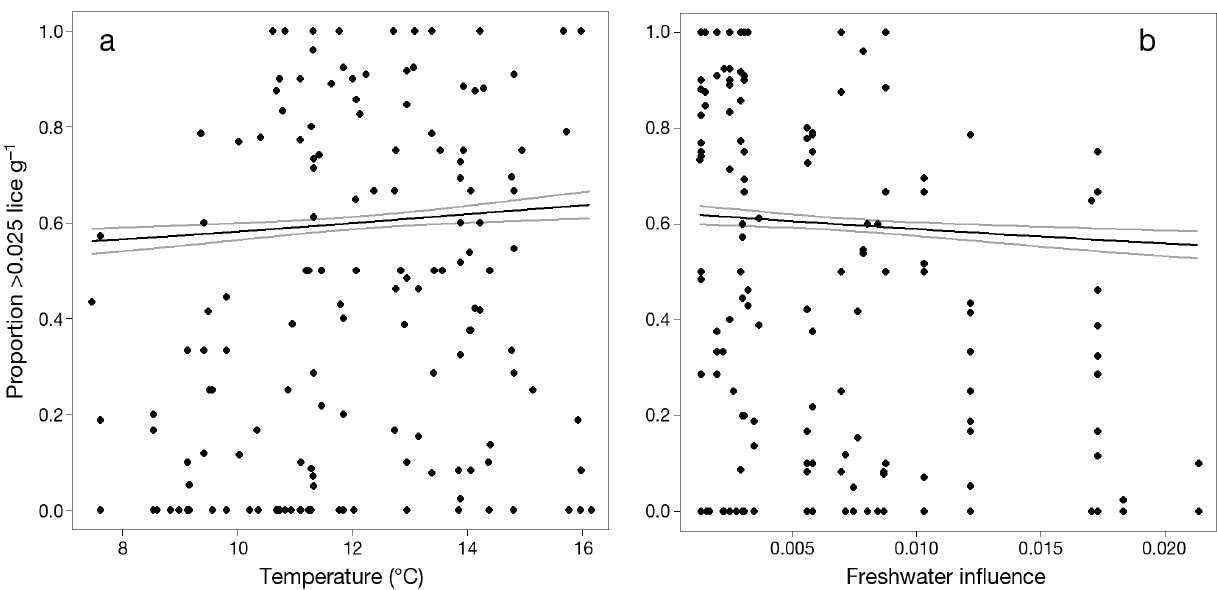
Fig. 5. Proportion of wild sea trout Salmo trutta with salmon lice Lepeophtheirus salmonis levels above 0.025 lice per gram fish weight (lice g −1 ) as a function of (a) temperature and (b) freshwater influence. Solid black lines represent predicted regression values (parameter values in Table 2), and grey lines show 95% confidence